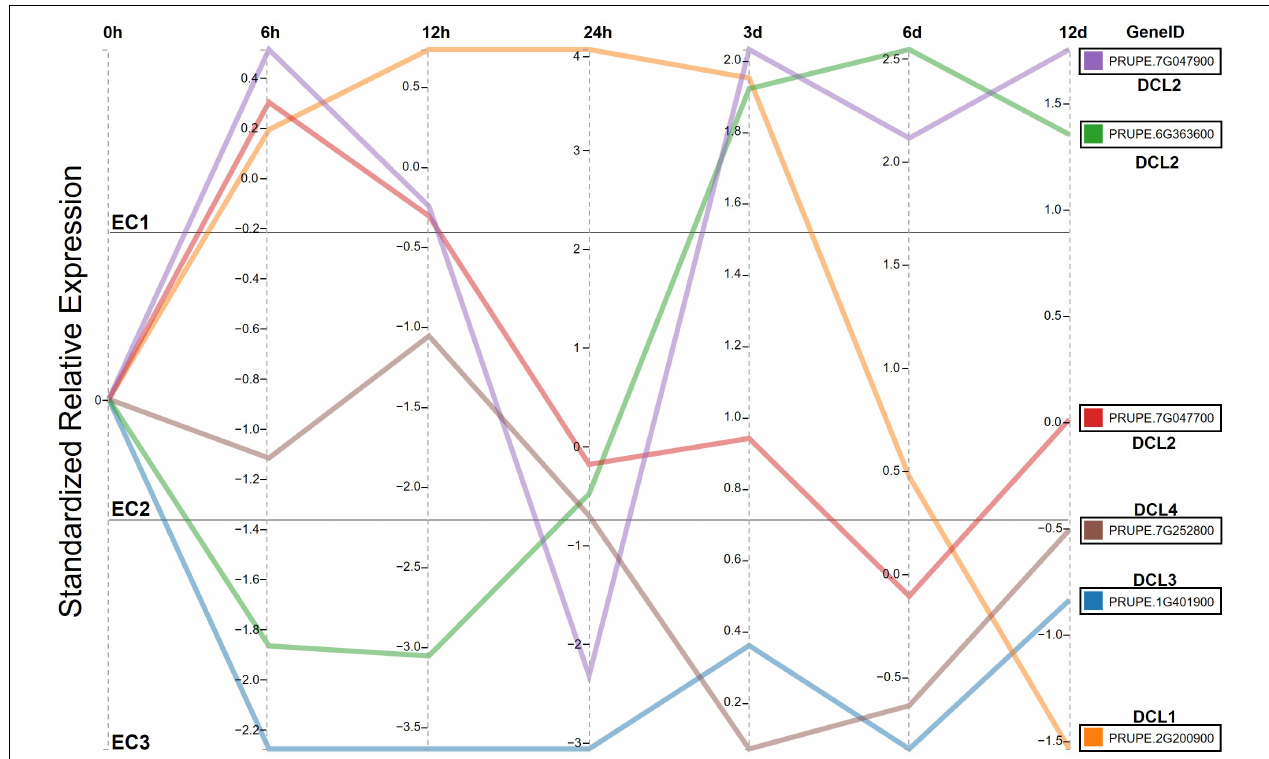
FIGURE 5 | Temporal trend for DCL genes expressed in the fruit flesh of P. persica exposed to drought stress over time periods: 0 h, 6 h, 12 h, 24 h, 3 days, 6 days, and 12 days stratified by 0 timing as a control. The timelines were aligned by the average of DCLs genes expression overtime by standardize relative expression. The expression area is divided into three expression clusters EC1, EC2 and EC3 to evaluate and categorize genes expressions. RNA data were used to measure the expression level of DCLs